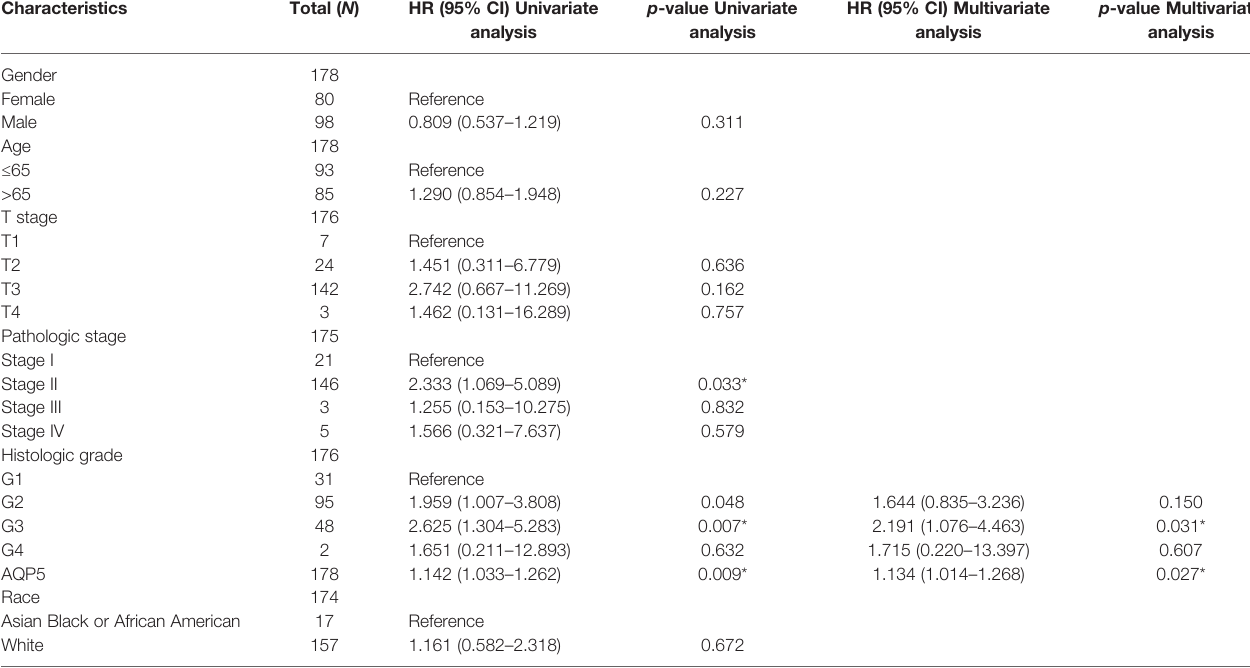
TABLE 2 | Univariate and multivariate Cox regression analysis of AQP5 expression for overall survival in patients with PAAD. Characteristics